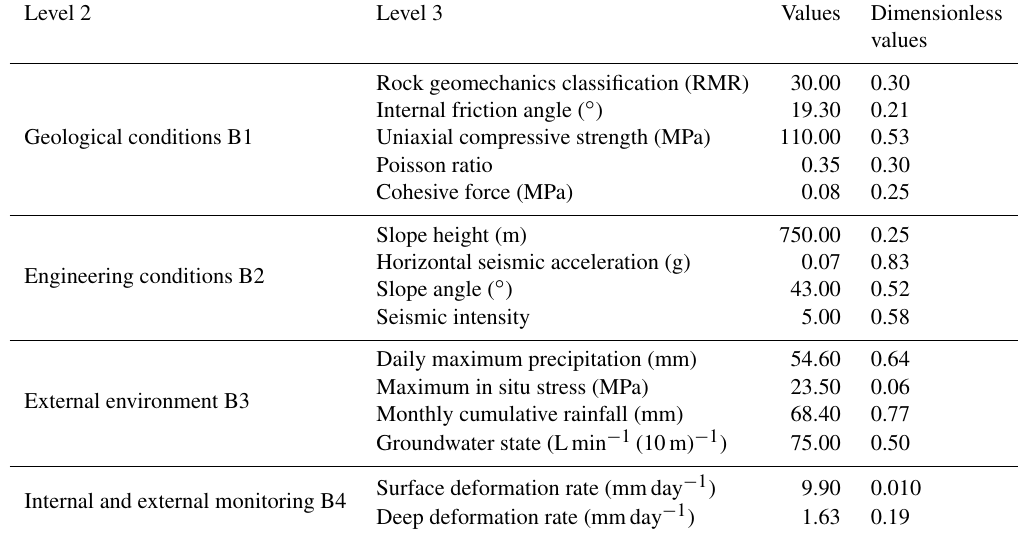
Table 5. Safety evaluation index value of high rocky slopes.